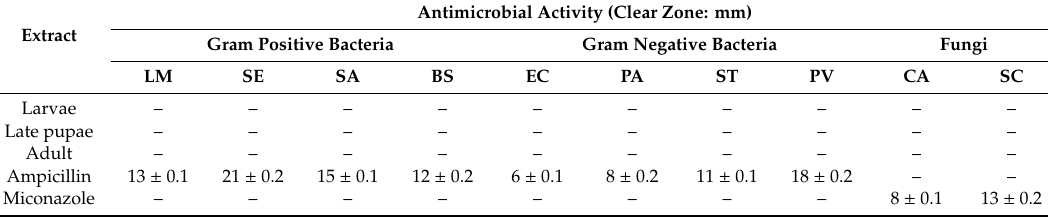
Table 5. Antimicrobial activities of hot water and ethanol extracts of Buckfast honey bee drone larvae, pupae and adults from Denmark against pathogenic and food spoilage microorganisms. The concentration of extracts and standard chemicals (Ampicillin and Miconazole) used were 500 µ g / disc and 1.0 µ g / disc,